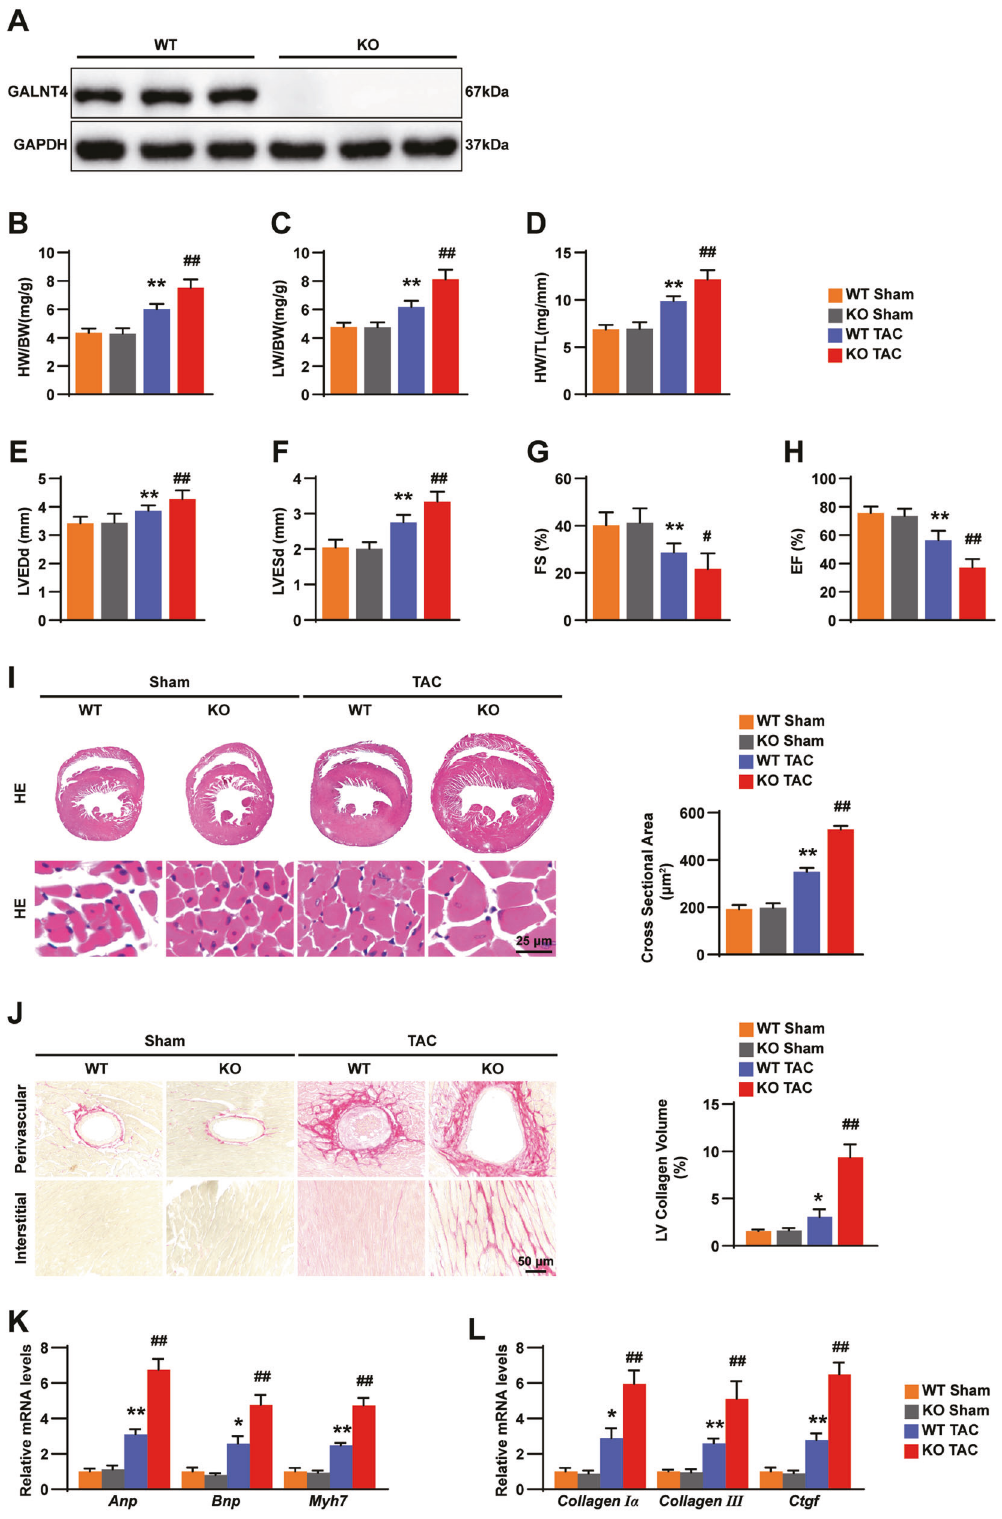
Fig. 3 GALNT4 de fi ciency accelerates cardiac hypertrophy in vitro. A The levels of GALNT4 in GALNT4-KO mice and WT mice were analyzed by western blotting. B – D The ratio of HW/ BW, LW/BW, and HW/TL in each group ( n = 10 mice per group). E – H LVEDd, LVESd, EF%, and FS% were analyzed in every group ( n = 10 mice per group). I H&E staining images ( n = 6 mice per group) and heart tissue CSA ( n = 120 cells in each group) in the GALNT4-KO group and WT control. J Images of PSR staining (left, n = 6 mice per group) and percentage of LV collagen volume in the indicated group. L , M The expression of hypertrophic and fi brotic markers were analyzed by qPCR ( n = 4 mice per group). * p < 0.05 vs. WT sham, ** p < 0.01 vs. WT sham, # p < 0.05 vs. WT TAC, ## p < 0.01 vs. WT